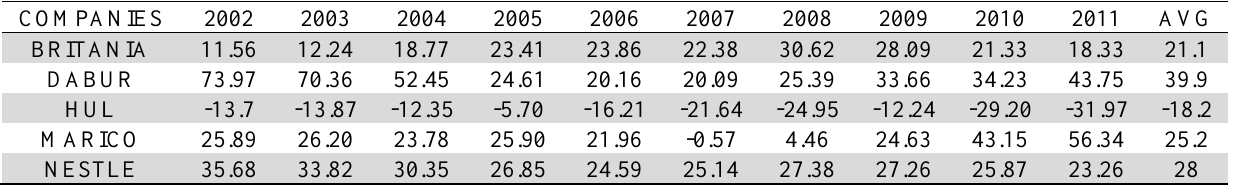
Analysis of Cash Conversion Cycle of Selected Companies of FMCG Sector (in Days)